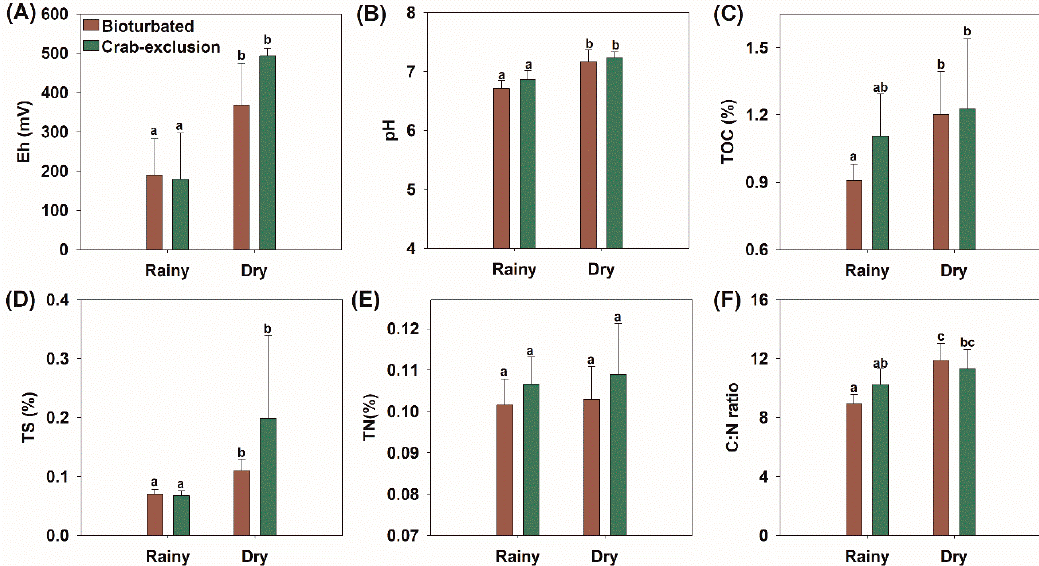
Figure 3. Soil measurements of mangrove soils for both bioturbated and crab-exclusion plots and over rainy and dry seasons. ( A ) In situ recorded redox potential (Eh), ( B ) in situ recorded pH, ( C ) total organic carbon (TOC), ( D ) total sulfur (TS), ( E ) total nitrogen (TN), and ( F ) C:N ratio. Labelled bars (standard error bars) with di ff erent lowercase letters (a and b) on the bars indicate statistical di ff erences among Seasons / Sites (Rainy / Bioturbated, Rainy / Crab-exclusion, Dry / Bioturbated, Dry / Crab-exclusion), at the 5% probability level (non-parametric Friedman test). p -values for each parameter are provided in Tables